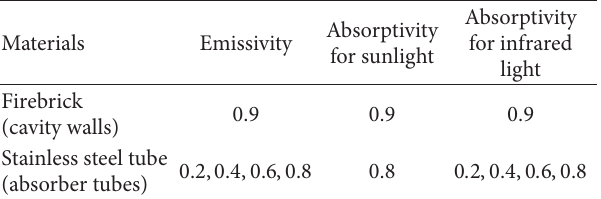
Figure 6: Sketch map of side-on wind. Table 1: Emissivity and absorptivity of the materials inside the